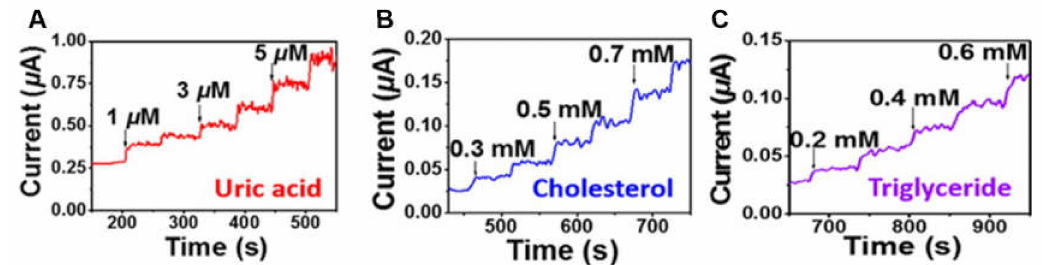
Figure 7. The conductive hydrogel as a biomolecular detector for di ff erent concentrations of ( A ) uric acid, ( B ) cholesterol, and ( C ) triglyceride [61]. Reprinted from [61] with permission from American Chemical